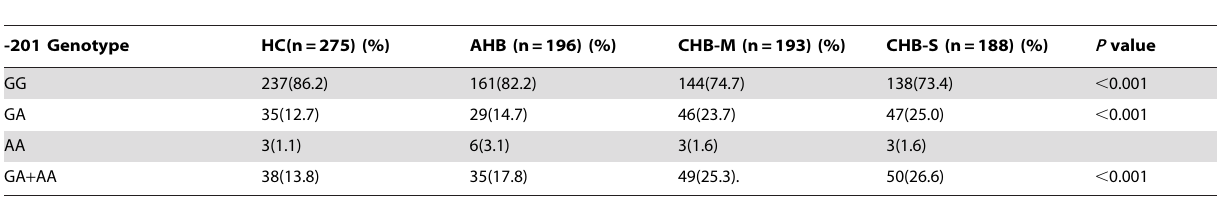
Table 2. G-201A frequencies linearly increased among different HBV groups.